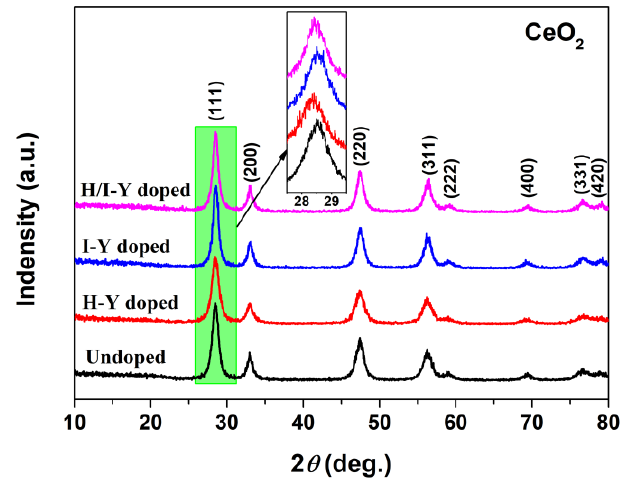
Figure 2. XRD patterns of Undoped and H-Y-, I-Y-, and H/I-Y-doped CeO 2 powders (the inset shows the (111) reflection shifts using a smaller scan speed of 0.01  /min). the (111) reflection shifts using a smaller scan speed of 0.01 ◦ /min).